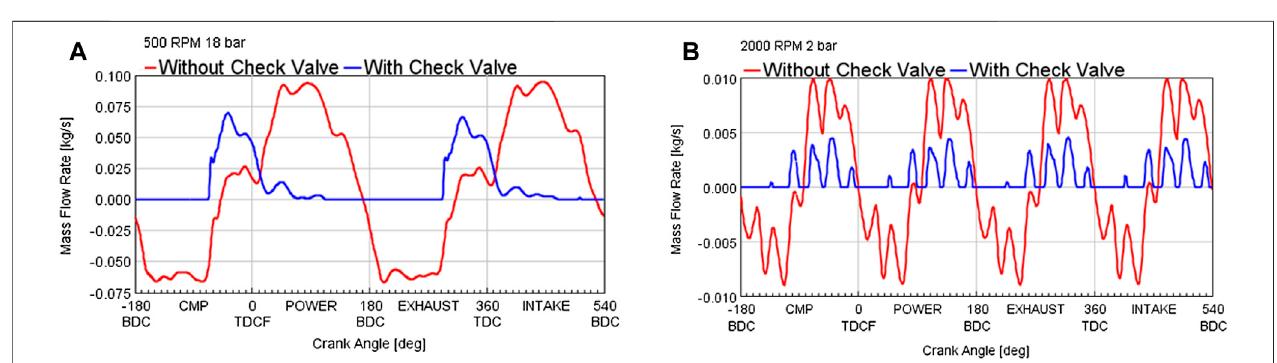
FIGURE 11 | One-way valve comparison at (A, left) 2,000 rpm, 2 bar BMEP; (B, right) 4,500 rpm, 18 bar BMEP.